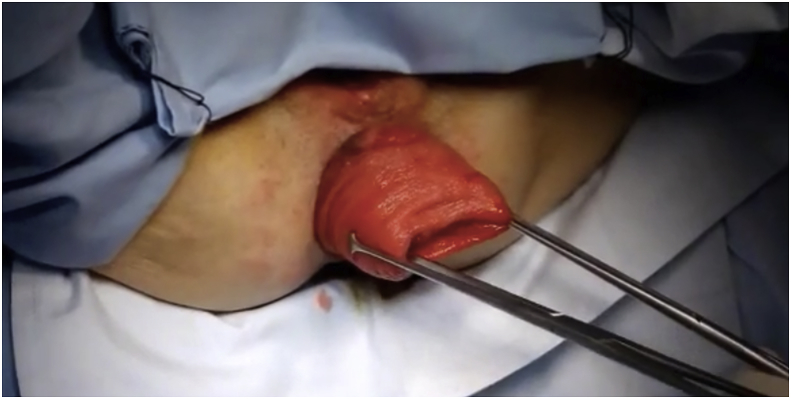
Rectal prolapse.